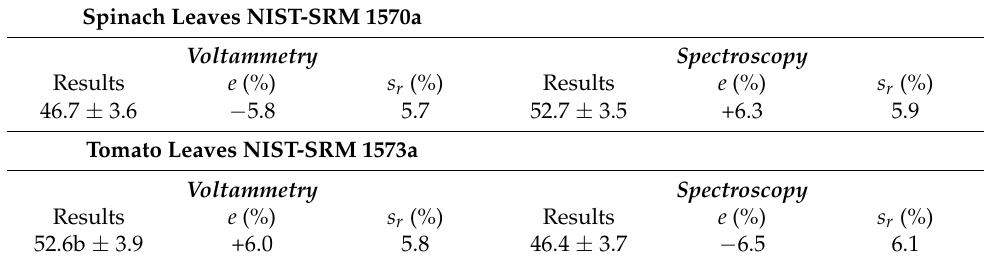
Table 2. Accuracy of the analytical procedure for the determination of Tl(I). The determined values are the mean of five independent determinations. Confidence level: 95%. Concentrations in µ g kg − 1 . Spiked sample concentration for all the elements: 49.6 µ g kg − 1 . The ratio of Tl to other analytes was the same as in Figure 2.